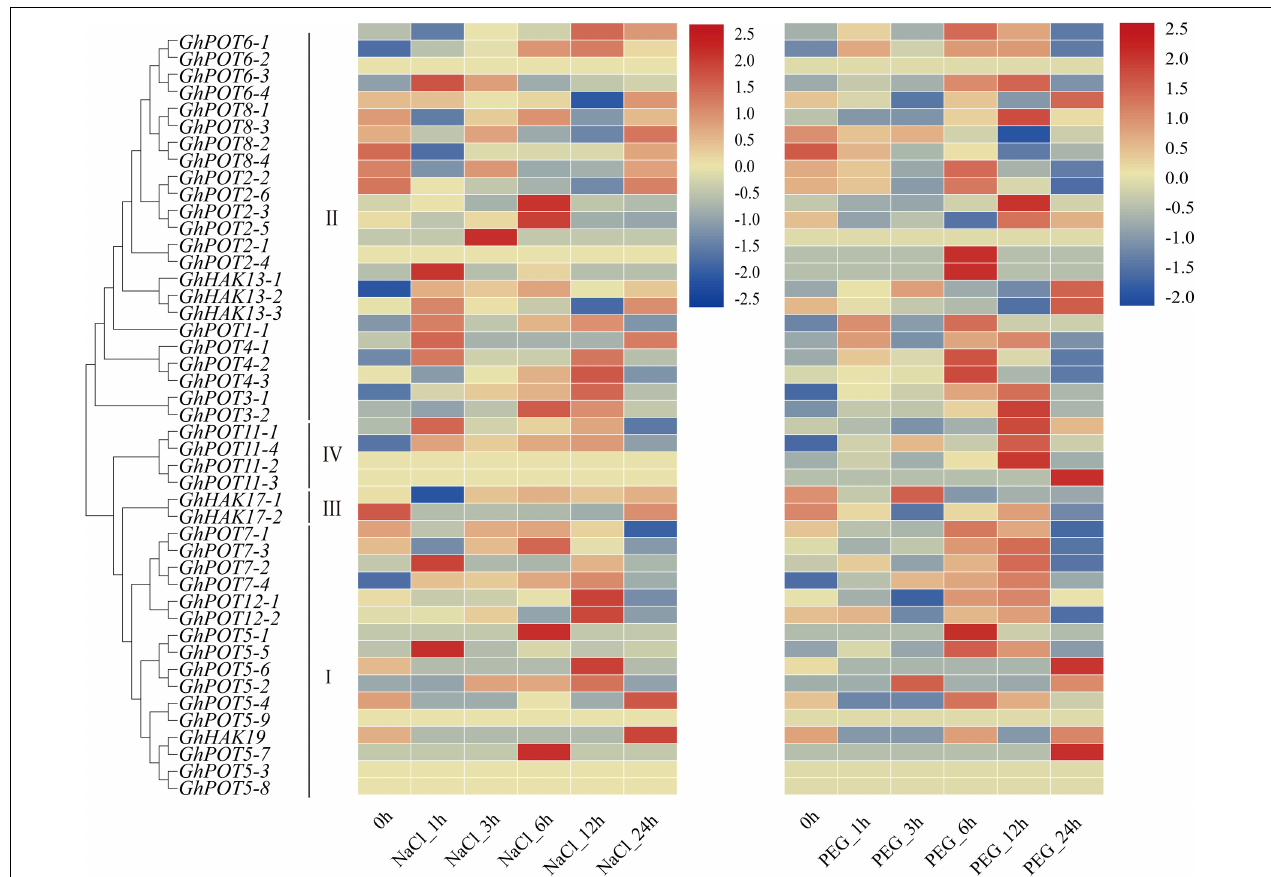
FIGURE 6 | Transcriptome data of GhPOTs in response to NaCl and PEG stresses. The treatments are shown at the bottom, and the genes and phylogenetic relationships are shown on the left. The scale bar on the right shows the colors used to represent the log2-transformed FPKM values for each gene.